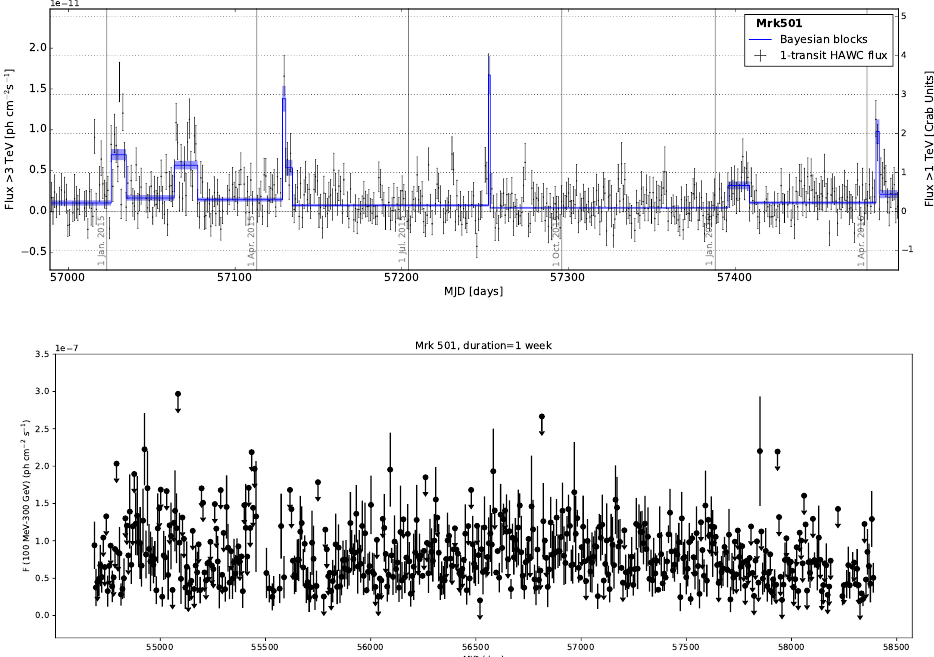
Figure 3. ( Top ) Light curve of Mrk501 as seen with HAWC from November 2014 to April 2016, with a daily sampling. The blue lines show distinct flux states from a Bayesian block analysis, from Abeysekara et al. [75]; ( Bottom ) long-term, weekly-binned light curve of Mrk501, as observed with Fermi -LAT for 10 years. Adapted from